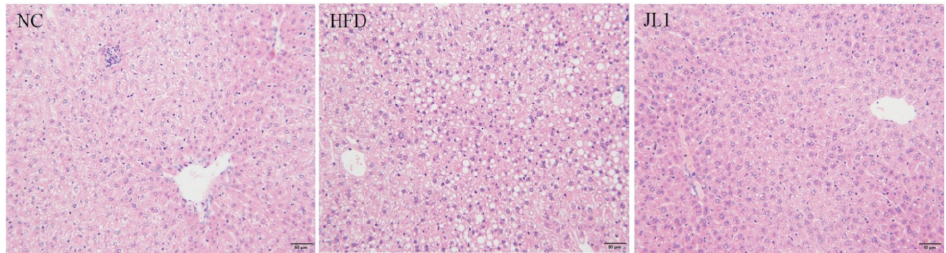
Figure 3. Image of liver section (scale bar = 50 µ